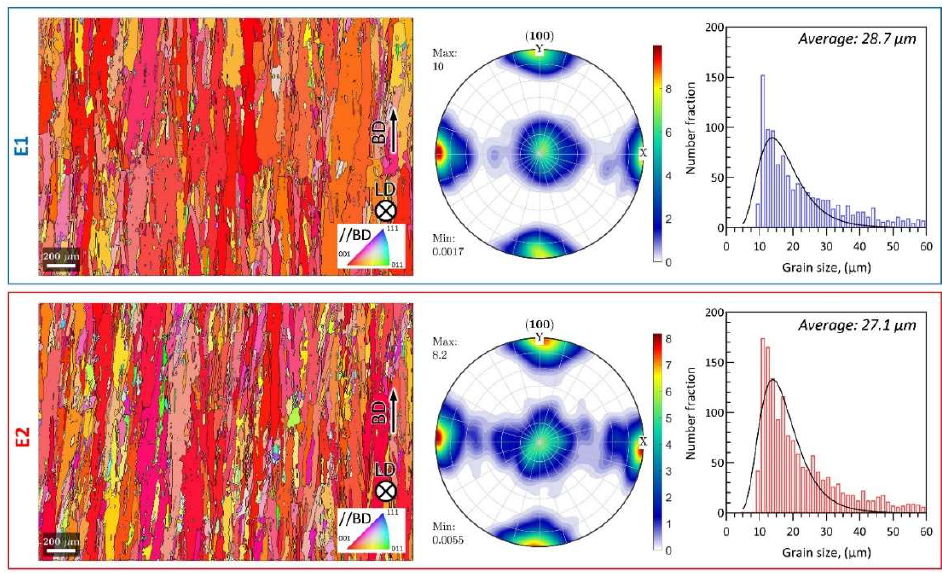
Figure 6. EBSD inverse pole figure coloring plots, grain size histograms and (100) pole figures of E1 and E2 samples before testing.